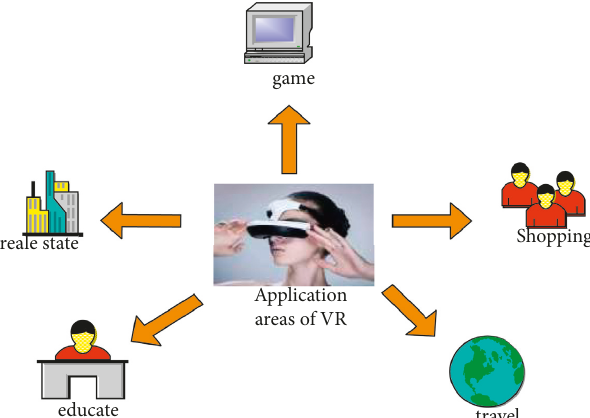
Figure 1: Application areas of